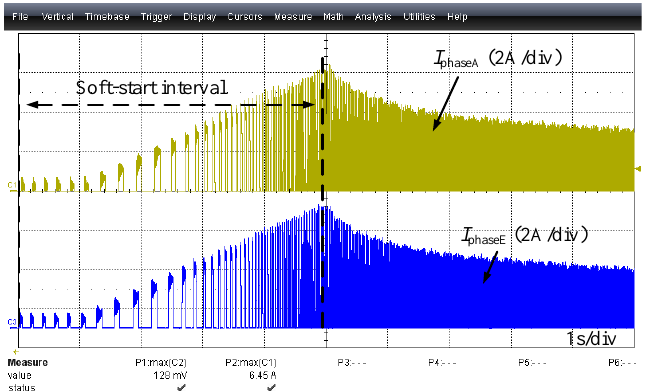
Figure 12. Soft-start current waveform.